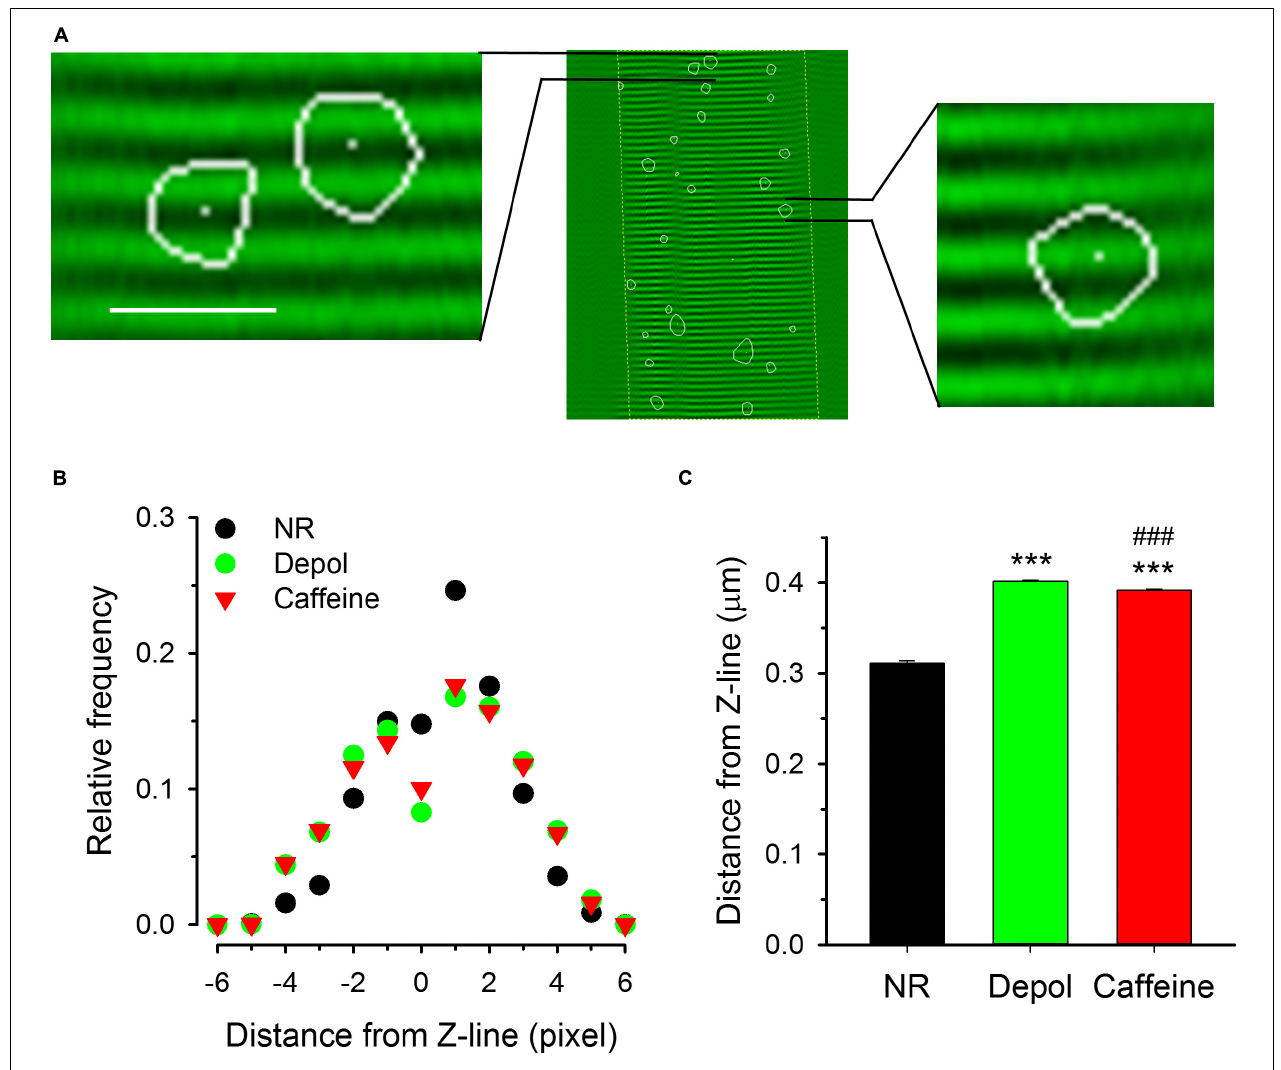
FIGURE 7 | Localization of spark centers relative to the Z-line. (A) Two samples from an image showing the fiber structure superimposed with sparks (indicated by the areas encircled by the white lines). White dots present the position of the center of the sparks. (B) Distribution histograms of the distance between center of sparks and the nearest Z-line for control conditions (NR, black circles), on depolarized fibers (green squares), and in the presence of caffeine (red triangles). Note that the distributions are essentially symmetric to the Z-line. (C) Mean distances of spark centers under the three conditions. Both the depolarization and the presence of caffeine shifted the center of the spark to positions further away from the Z-line as compared to the control conditions. Scale in panel A corresponds to 40 µ m for the middle image and 4.3 µ m for the enlarged images on left and right side. The middle image was recorded with 30 FPS. Here and in subsequent figures *** denotes significant difference versus NR at p < 0.001, ### denotes significant difference vs. Depol at p <